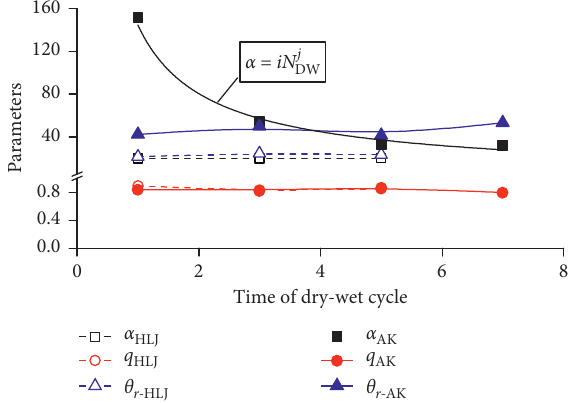
Figure 12: The fitting curves using Gardner model under different times of the dry-wet cycle.